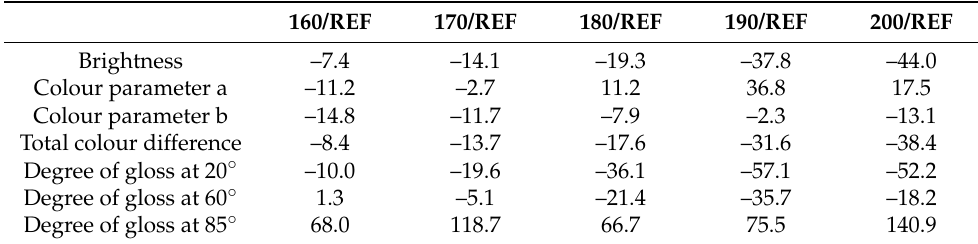
Table A2. Changes in colour and gloss parameters of heat-treated birch wood in comparison to the reference (untreated) birch wood in %; including